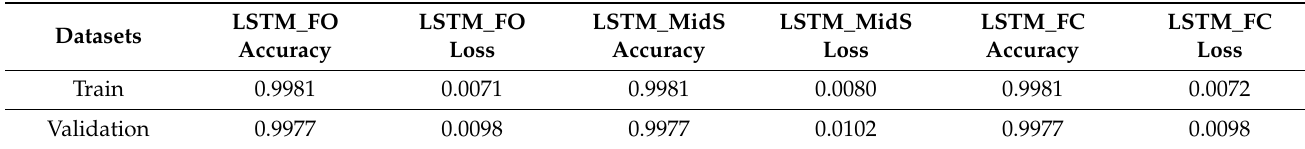
Table 2. Accuracy and loss on train and validation datasets.